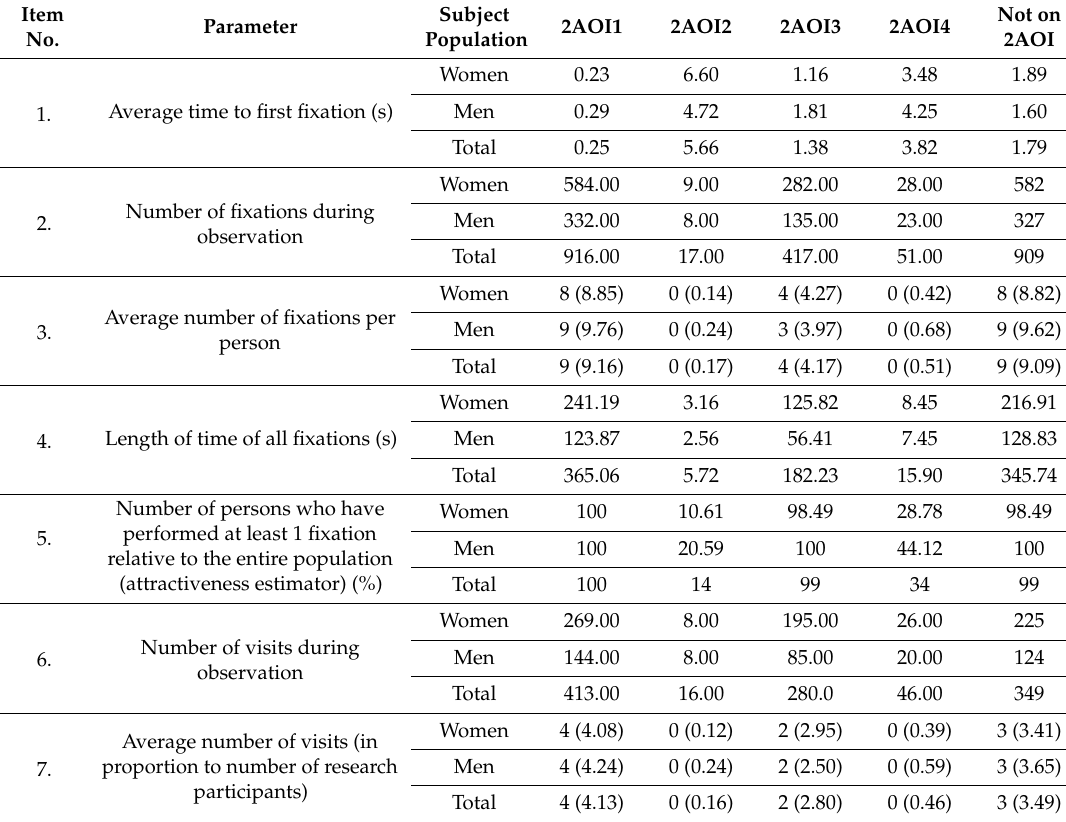
Table 3. Parameters describing the process of the observation of areas outlined on image 2. Item